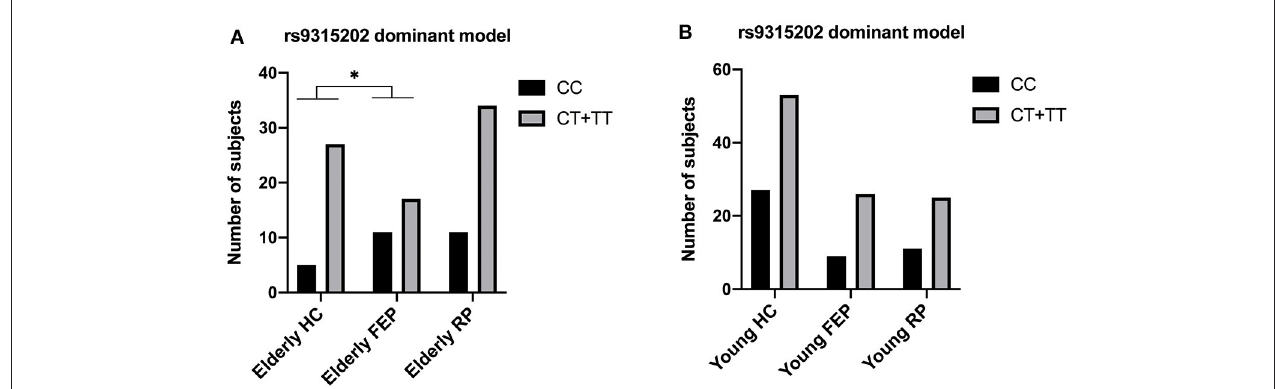
FIGURE 2 | Genotyping and dominant model distributions of SNP rs9315202 in the elderly (A) and young (B) participants. HC, healthy controls; FEP, first episode patients; RP, recurrent patients; * P < 0.05.